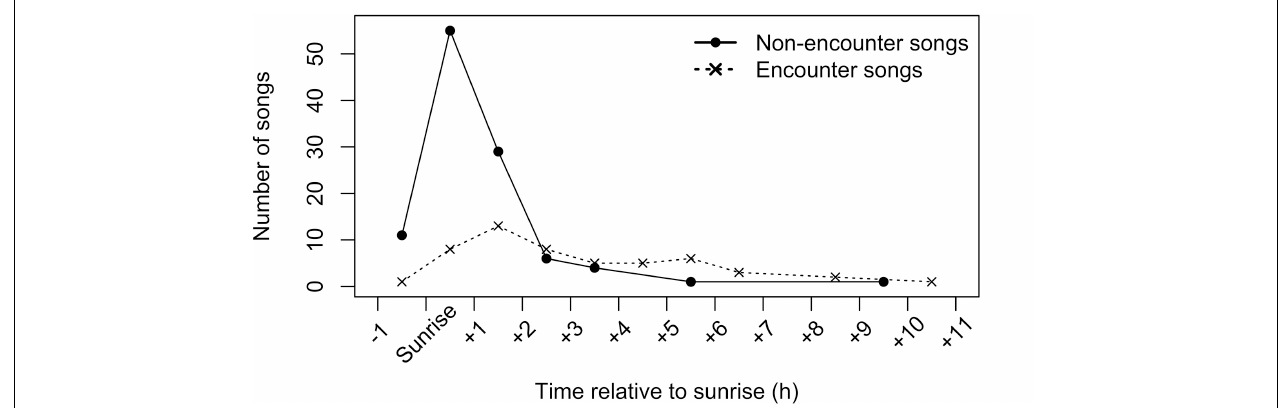
FIGURE 5 | Temporal distribution of songs. Shown are numbers of songs that started in each 1-h interval relative to sunrise time on a given day, separately for the encounter (total N = 52 songs) and non-encounter (total N = 107 songs) contexts, for eight study